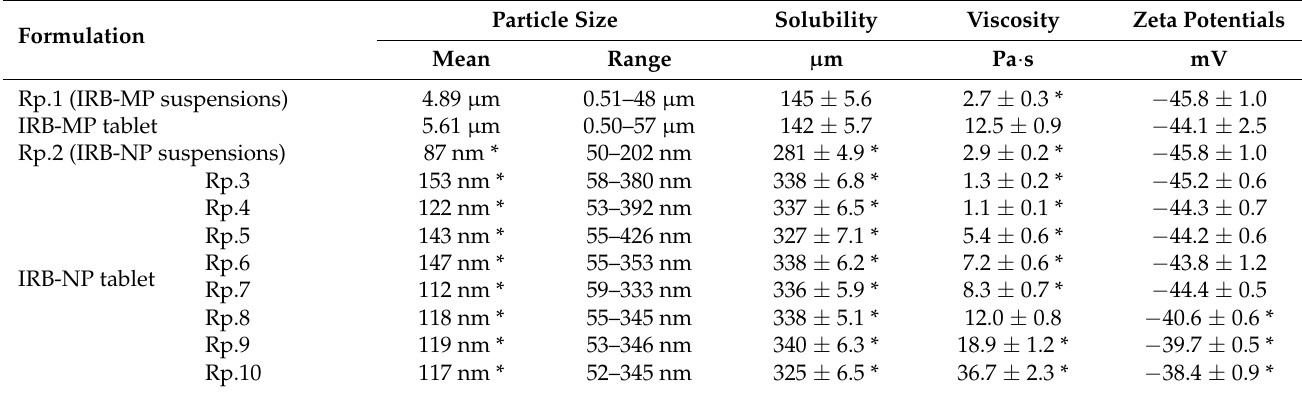
Table 2. Characteristics of the redispersed IRB